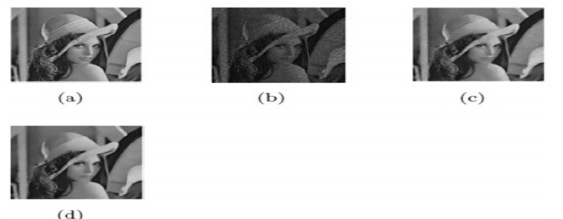
Fig. 2: Reconstructed results on Lena Image; (a) True Image; (b) Lena with multiplicative noise l 1 = 0.09; (c) Obtained Result by Method M1 ( λ = 443); (d) Obtained result by Method M2 ( λ = 354, c = 1.74)